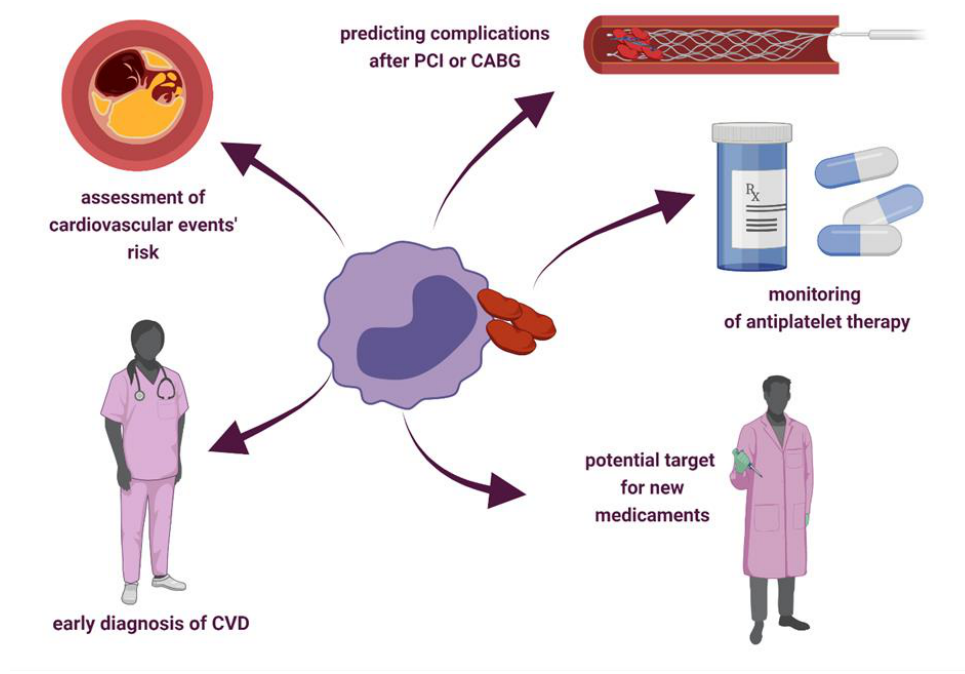
Figure 2. Potential clinical applications of platelet – leukocyte aggregates. Abbreviations: CABG — coronary artery bypass grafting; CVD — cardiovascular diseases; PCI — percutaneous coronary intervention.